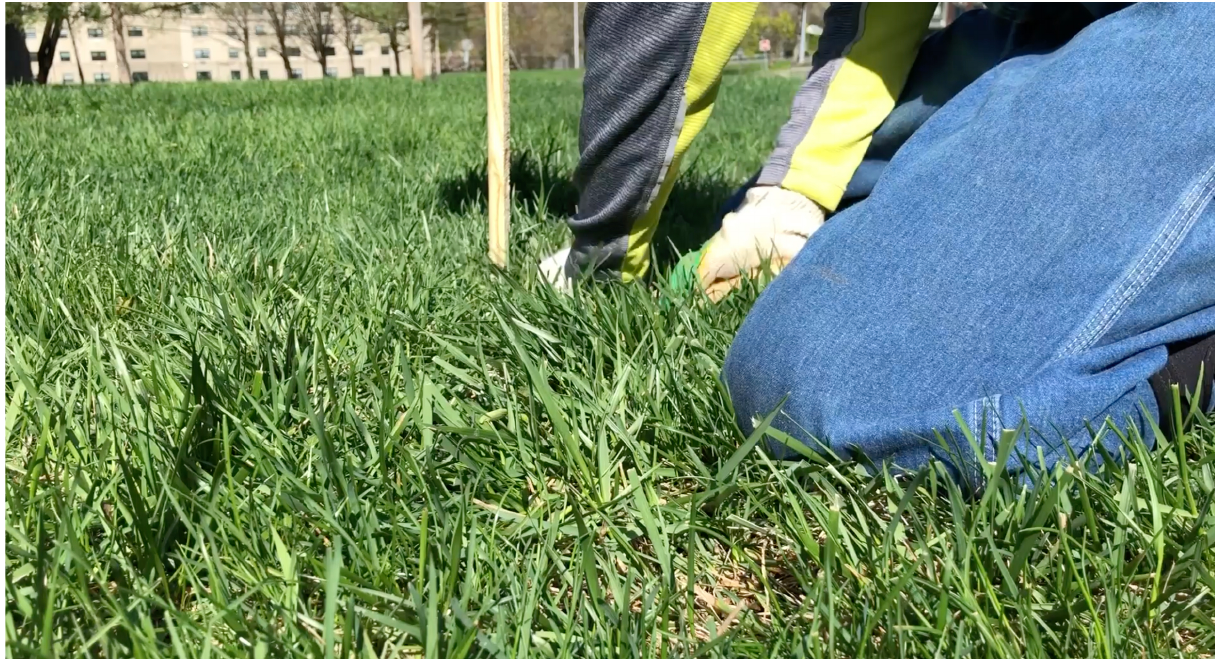
Figure 6: Video documentation of the establishment of Lawn Lab plot #1 on the campus of Rensselaer Polytechnic Institute in March 2018. This plot was sited on a patch of lawn between two access roads and a parking lot. Video available at: